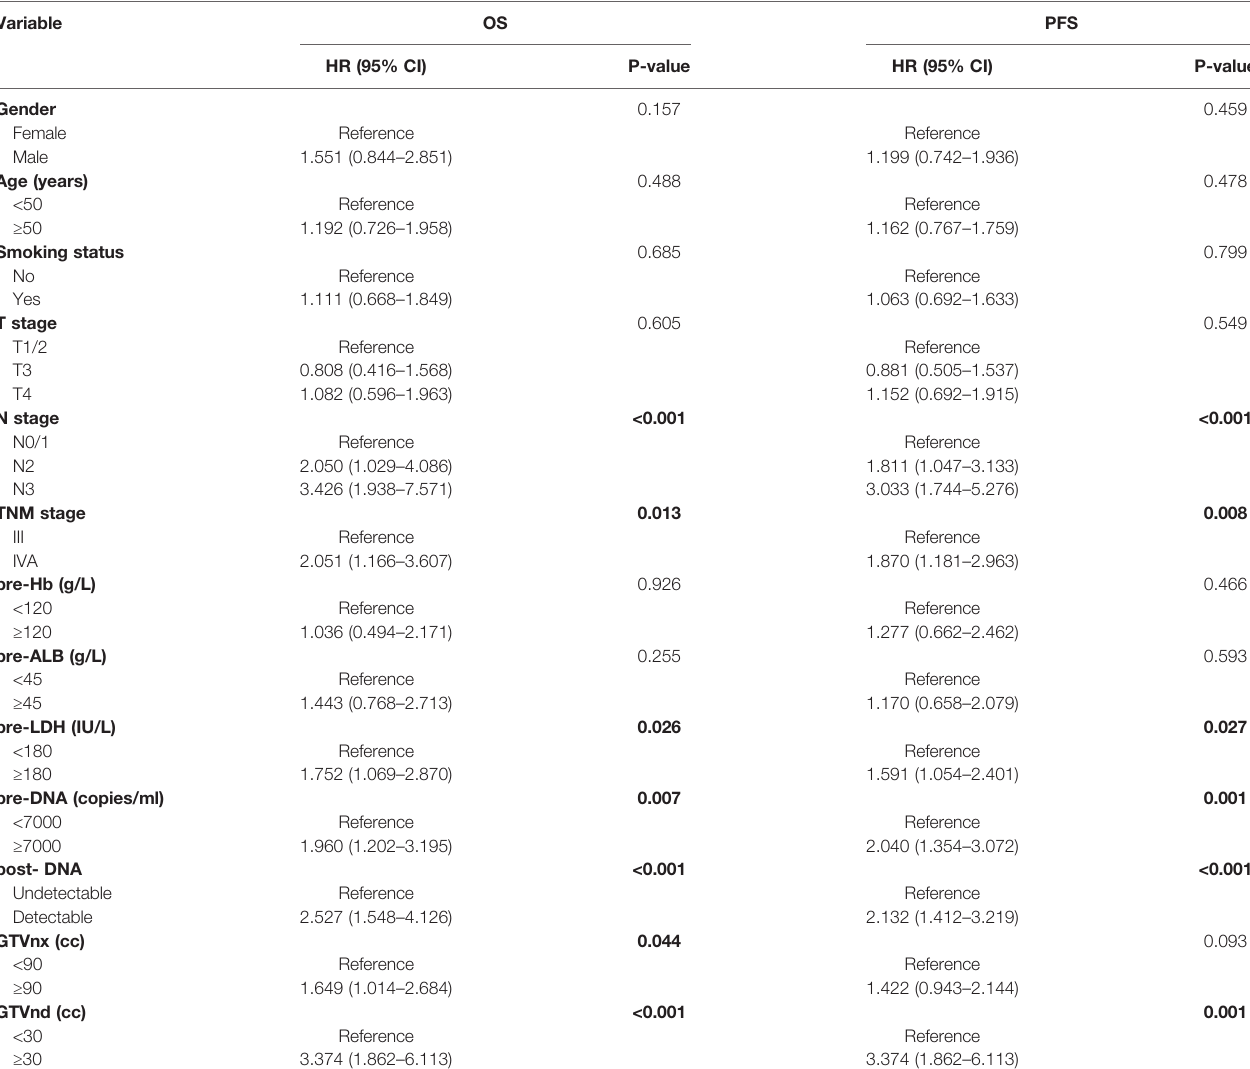
TABLE 2 | Identi fi cation of risk factors of OS and PFS by univariate Cox models.